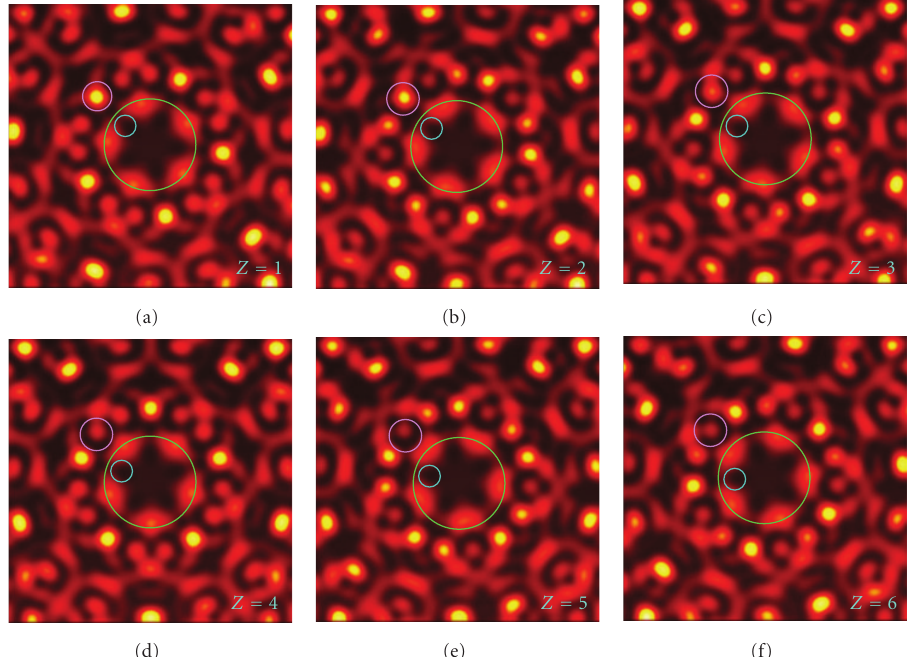
Figure 9: Computational analysis of spiraling complex 3D vortex lattice formed in the presence of a perturbing beam and a fivefold multiple of relatively phase-shifted three beams leading to 15 + 1 noncoplanar multiple beam interference. (a)–(f) The intensity distributions of x - y planes while the value of “ Z ” is varied along the direction of propagation. The circled region (cyan) visualizes the spiraling vortex distribution, and the circled region (magenta) depicts how the energy gets coupled to the adjacent region, while the complex vortex lattice structure makes a whirling movement along the direction of